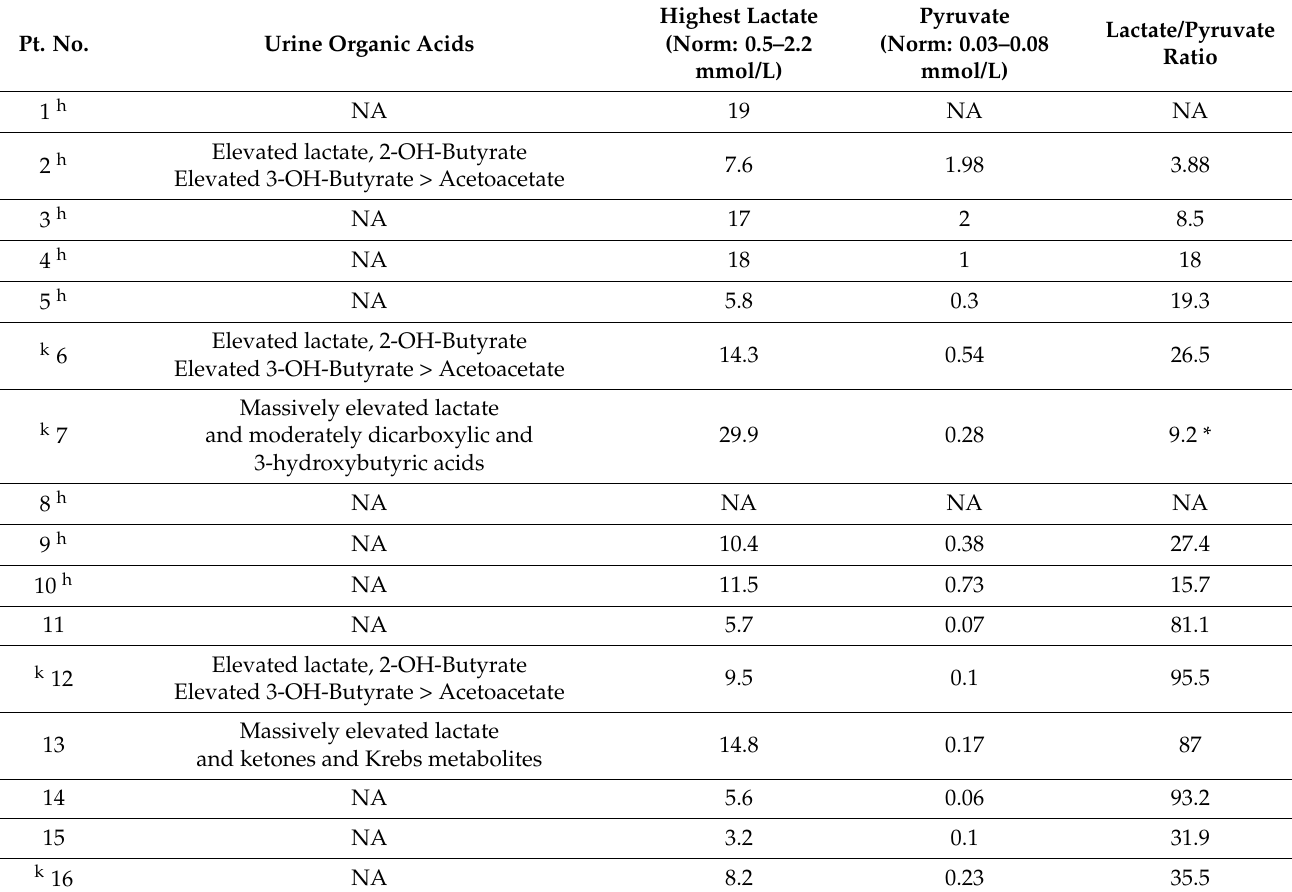
Table 4. Biochemical studies in patients with dihydrolipoamide dehydrogenase deficiency. Pt. No.